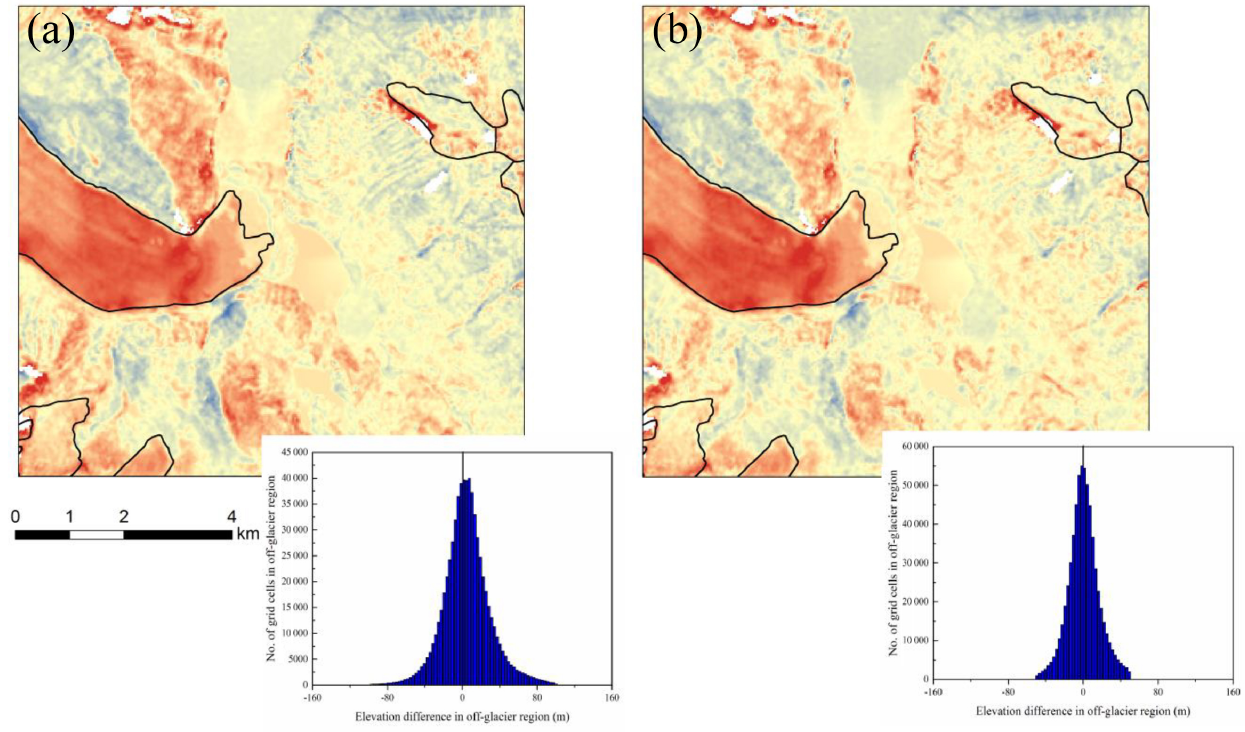
Figure 4. Elevation differences estimated between SRTM and TOPO DEMs before (a) and after (b) co-registration, northern slope of the Kangri Karpo. Location of the data example is shown in Fig.